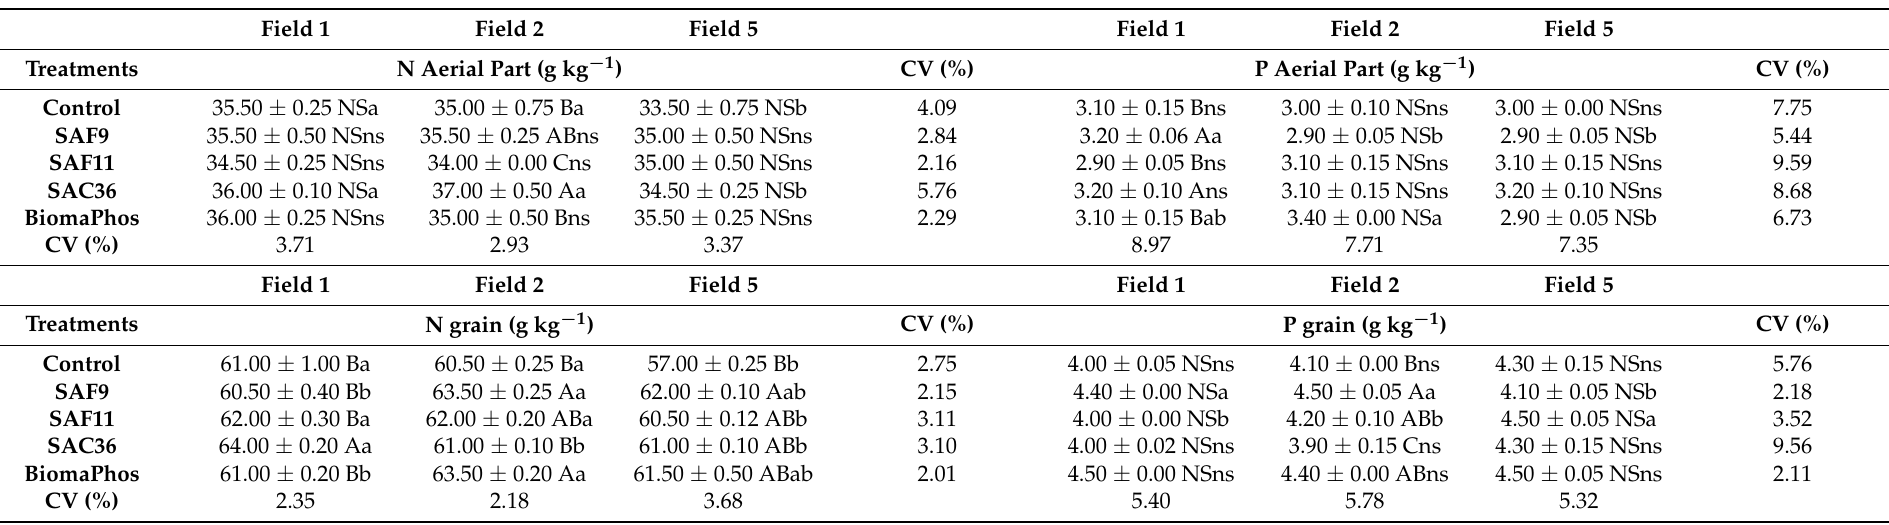
Table 3. Effect of inoculation with plant-growth-promoting rhizobacteria on nitrogen (N) and phosphorus (P) contents in the aerial part and grains of Glycine max L. plants grown in summer 2019/2020, in three experimental fields of soybean cultivation, in the interior of the state of Goi á s, Brazil, with different soybean cultivation histories: Field 1, soybean production for 30 years; Field 2, soybean production for 15 years; and Field 5, first year of soybean